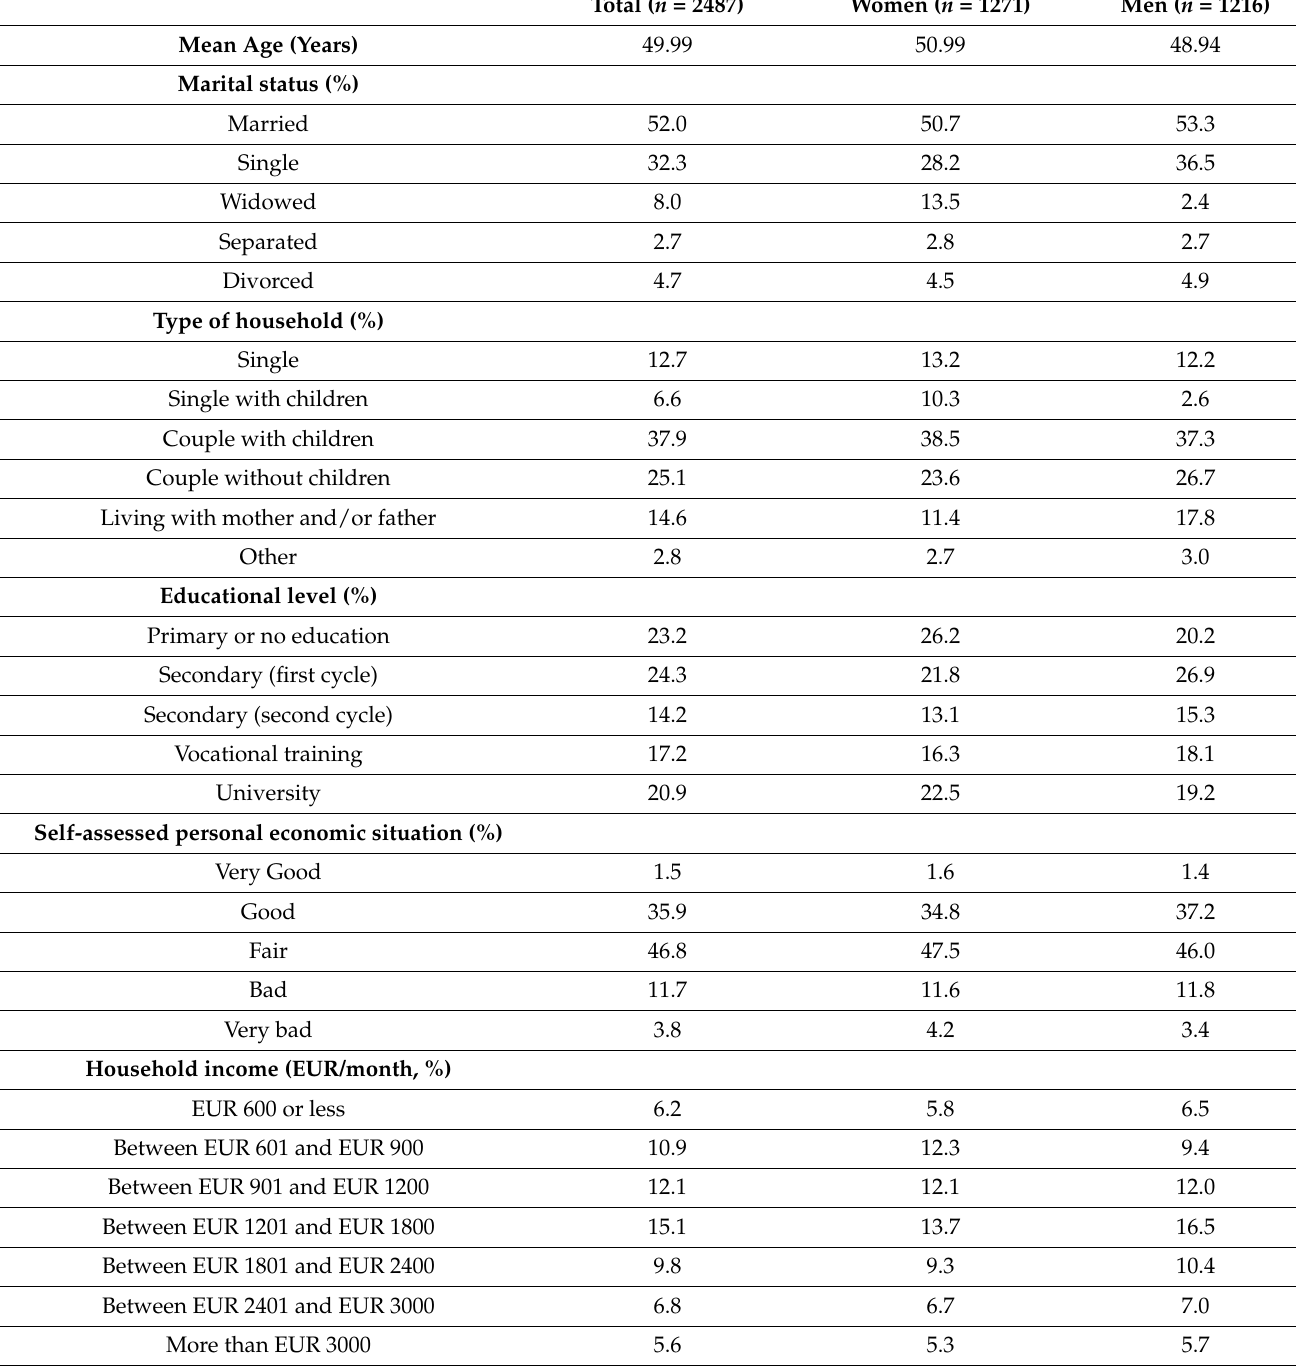
Table 1. Sociodemographic characteristics of the study